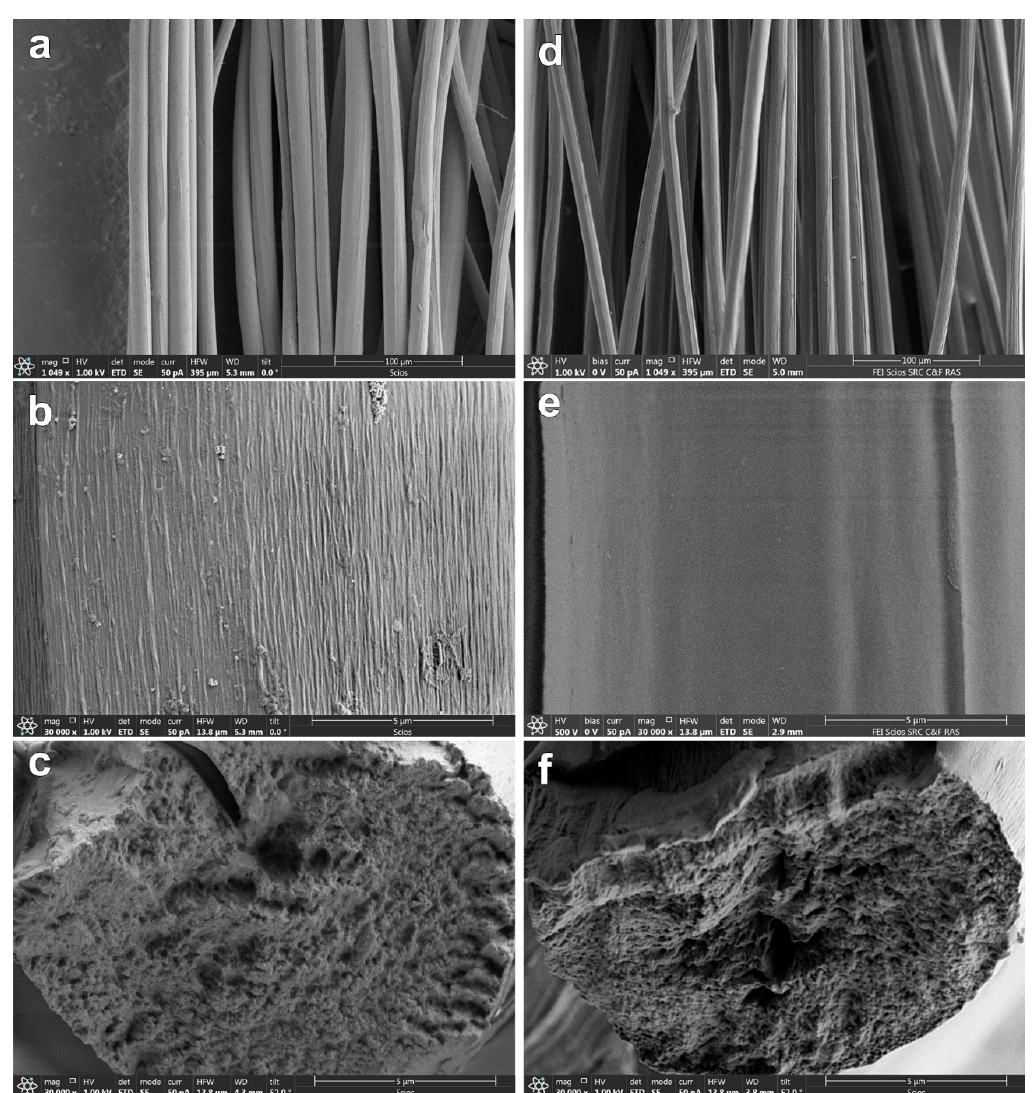
Figure 7. SEM micrographs of cellulose fibers after precipitation into isobutanol T = 25 °C ( a – c ) and T